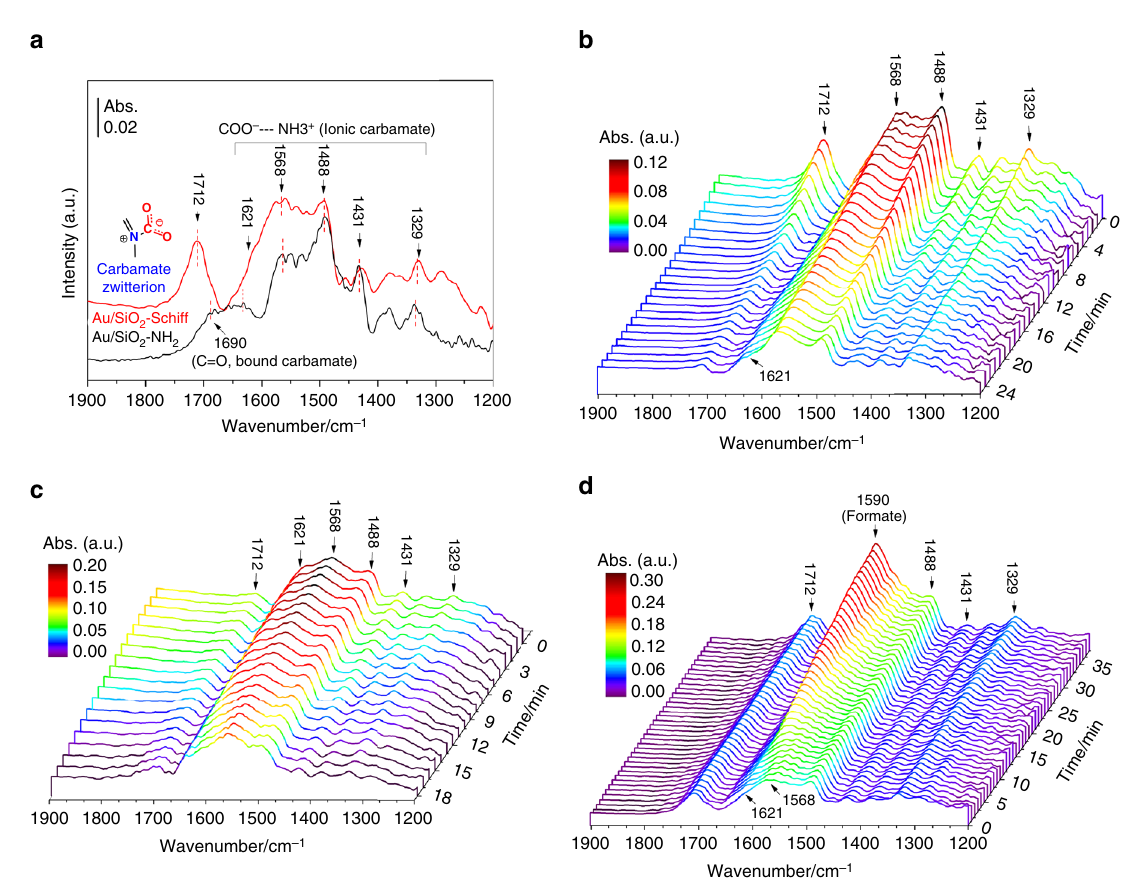
Fig. 2 Spectral analysis of the gold catalysts during CO 2 adsorption/hydrogenation. a FTIR spectra of Au/SiO 2 -NH 2 and Au/SiO 2 -Schiff under a humid CO 2 atmosphere. b Time-resolved DRIFTS spectra of the Au/SiO 2 -Schiff catalyst after wet-CO 2 evacuation. In situ DRIFTS spectra of the CO 2 hydrogenation reaction over Au/SiO 2 -Schiff catalyst without c and with d the presence of a surface-bonded carbamate